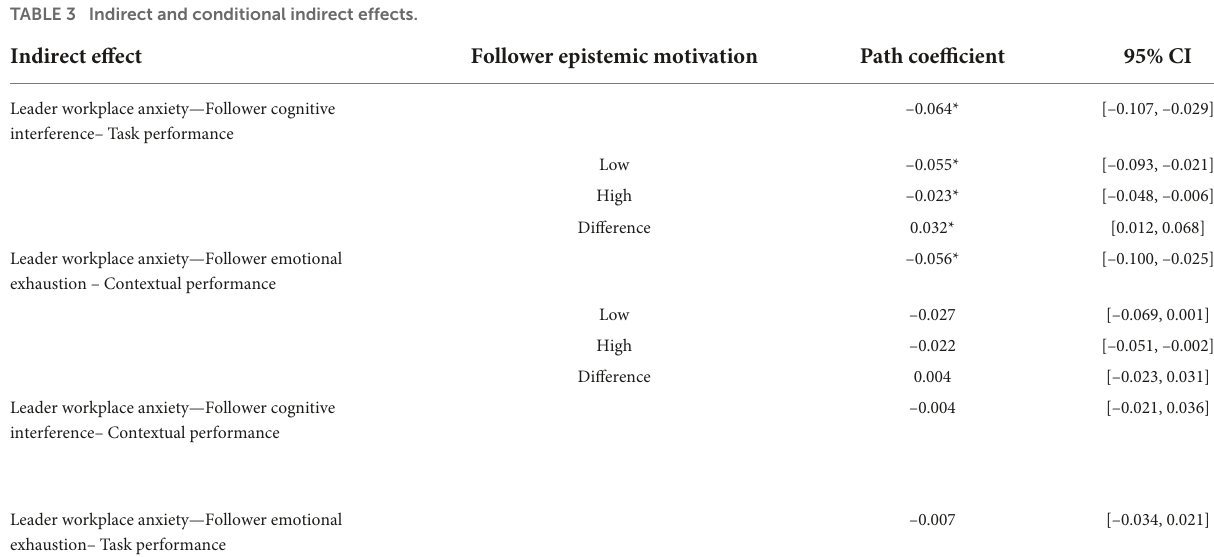
TABLE 3 Indirect and conditional indirect